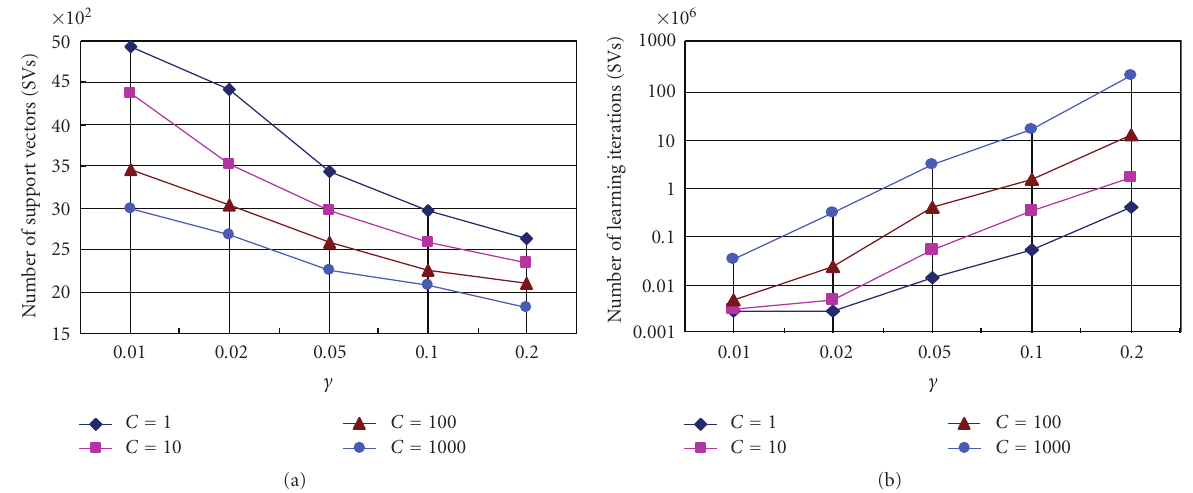
Figure 10: (a) Number of SVs versus γ ; (b) Number of learning iterations versus γ (model Meng versus Others parameterized with C